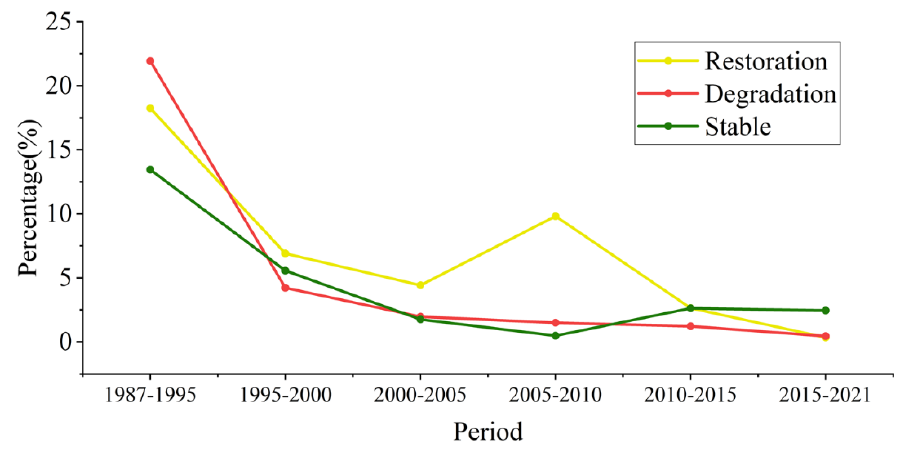
Figure 7. Percentage of area exhibiting the beginning of the change processes.